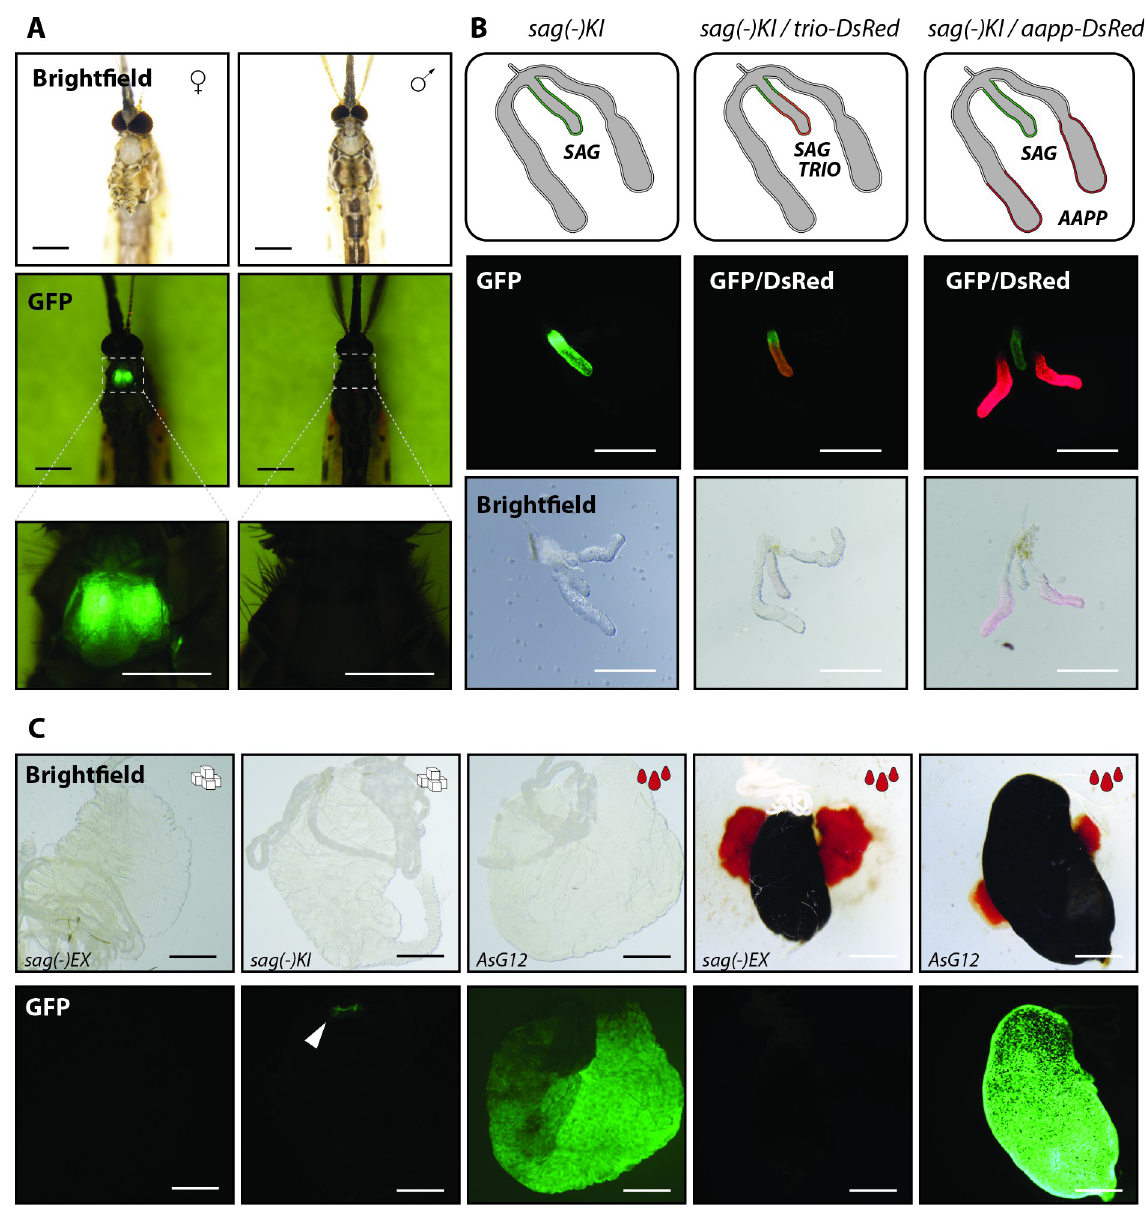
Fig 4. Saglin is exclusively expressed in the median lobes of the salivary glands of female mosquitoes. A) Brightfield images (top) and GFP signal in a homozygous sag(-)KI female and male mosquito. Scale bar: 0.5 mm. Bottom panels: close-ups of the GFP signal in the thorax. Scale bar: 250 μ m. Male and female mosquitoes were imaged seven days after emergence using the same settings. B) Sag(-)KI females were crossed to males of the salivary gland reporter lines trio-DsRed and aapp-DsRed . Salivary glands of heterozygous F1 females were dissected and imaged. The genotypes as well as the expected expression patterns within the salivary glands are shown on the top. Fluorescence (middle) and brightfield (bottom) images of the same salivary glands. Scale bar: 250 μ m. C) Comparison of EGFP expression in a sugar fed sag(-)KI midgut compared to sugar and blood fed sag(-)EX midguts. As positive control, midguts of the An . stephensi line AsG12 which expresses EGFP under control of the blood meal inducible promoter G12 are shown [23]. Adults were dissected 7–10 days post emergence. Displayed AsG12 midguts were dissected either four days after blood feeding (blood already digested) or 24hrs after blood feeding (blood filled). The white arrow indicates the EGFP expressing pyloric valve in sag(-)KI resulting from activity of the 3xP3 promoter. Scale bar: 250 μ m.